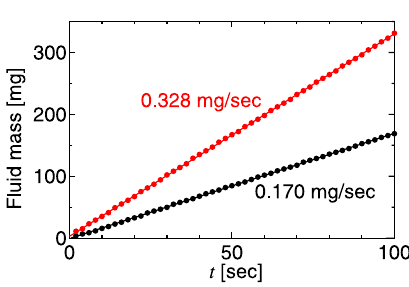
Fig. 3 The time series of the fluid mass increment in the outlet tank.